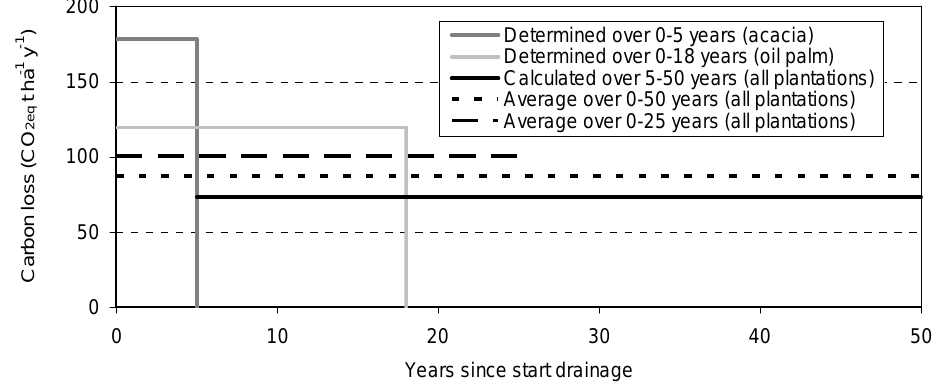
Fig. 6. Development in carbon loss over time in the Acacia and oil palm plantations studied. Presented are the values over 5 years and 18 years as determined for Acacia and oil palm plantations respectively, as well as long-term averages.